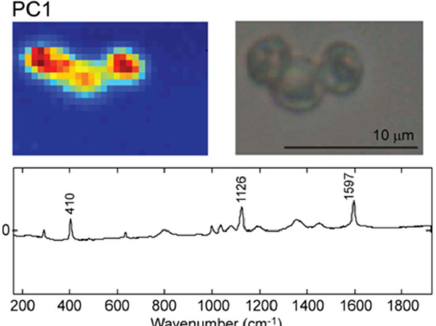
Figure 3 Figure 2. Top left: The false color Raman map of nonloaded microcapsules. Top Right: Optical microscopy image of nonloaded microcapsules. Bottom: The corresponding loading plot of the relevant principal component principal component 1 (PC1).